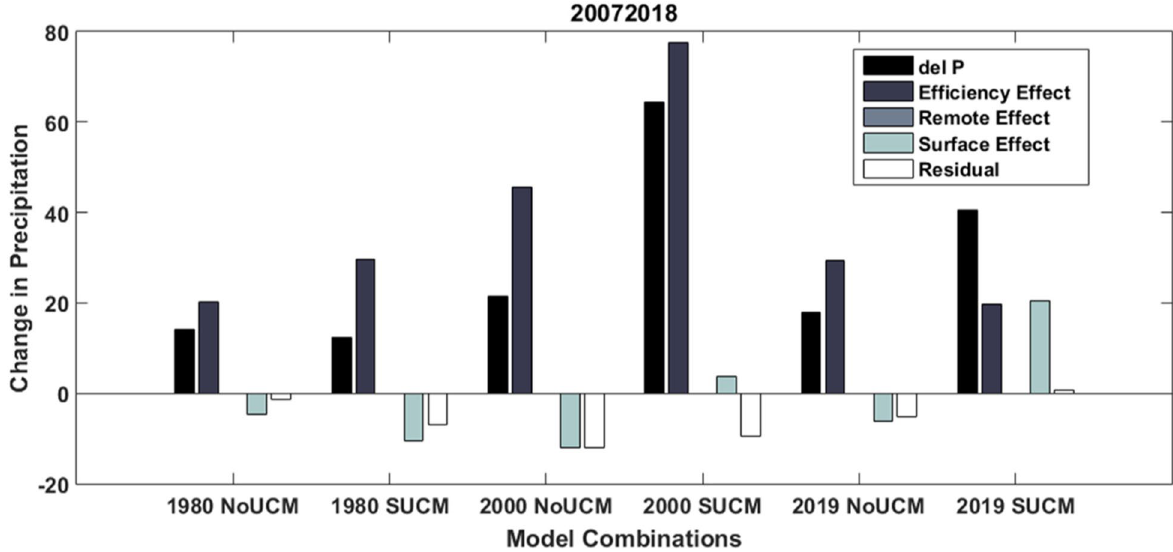
Fig. 11 Surface-Precipitation Feedback for the heavy rainfall day “x” and “y”